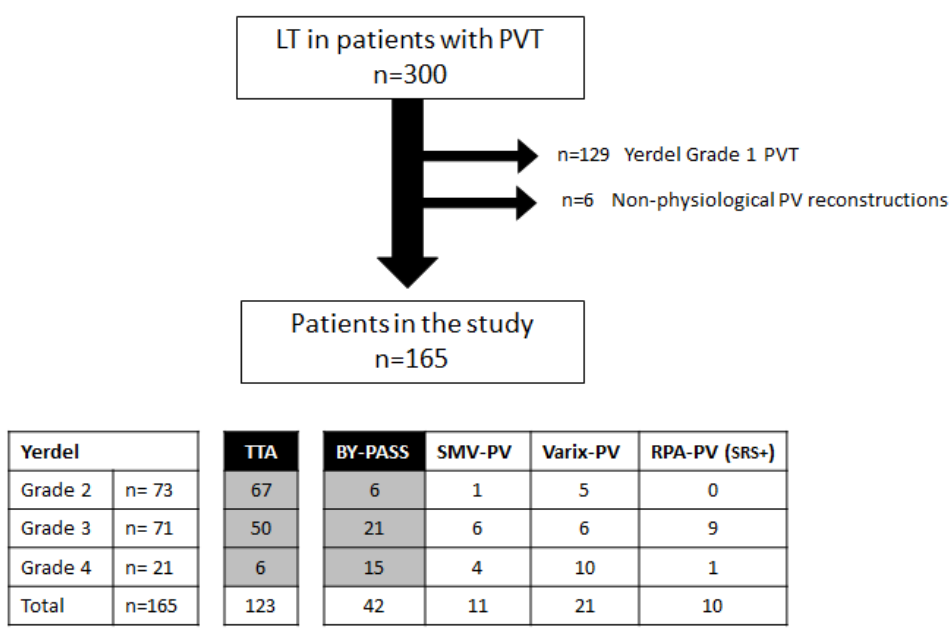
Figure 2. Diagram flow with the population of the study.